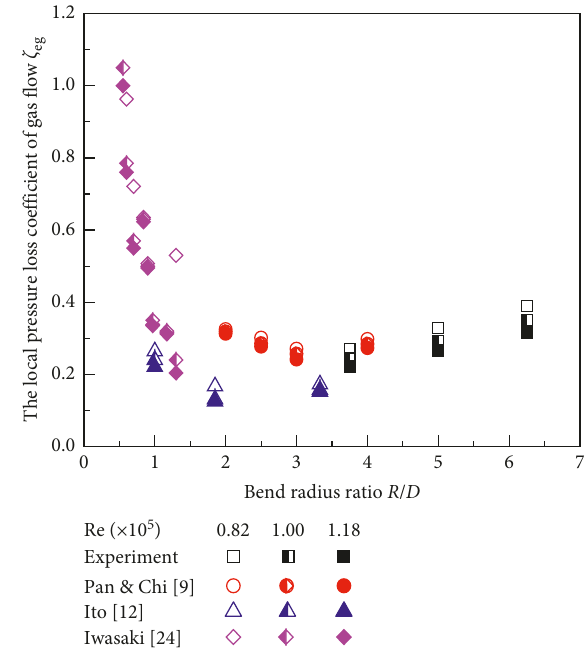
Figure 7: Relationships between local pressure loss coefficient (only airflow) and bend radii for the different Re.